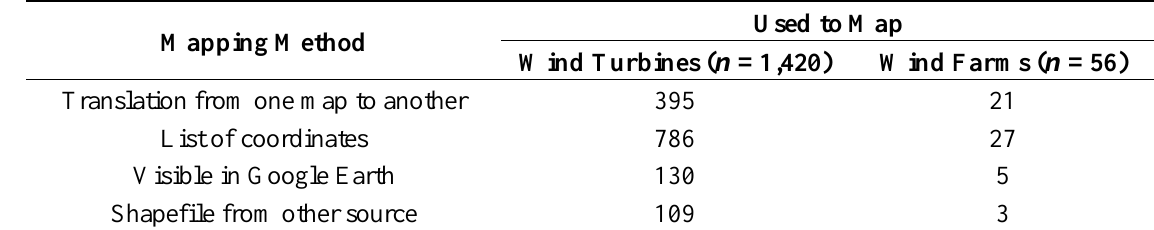
Table 3. Methods used to map wind turbines.